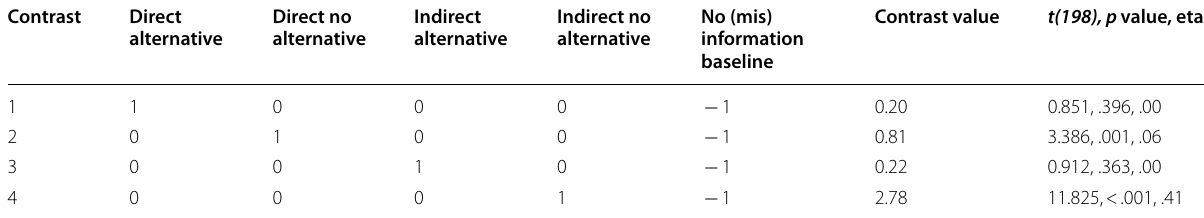
One-way ANOVA, F (4, 213)